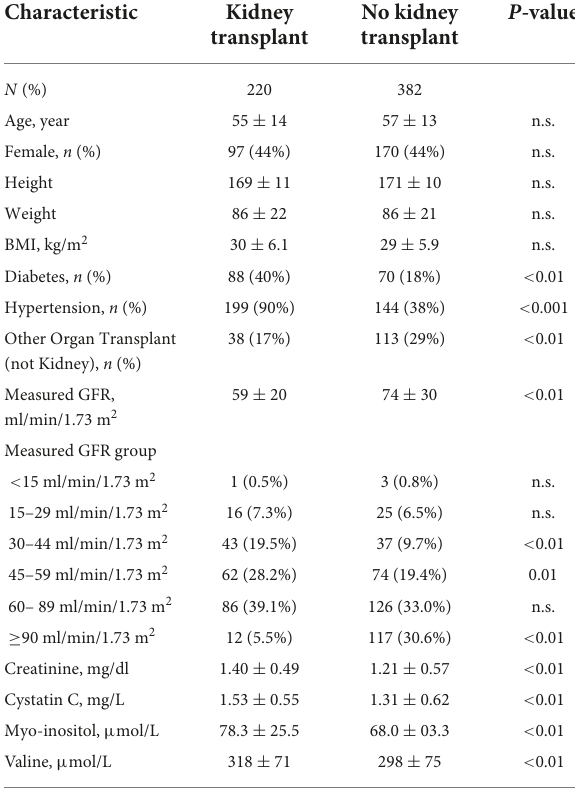
TABLE 1 Demographic, clinical and laboratory findings among patients with a clinically ordered measured GFR